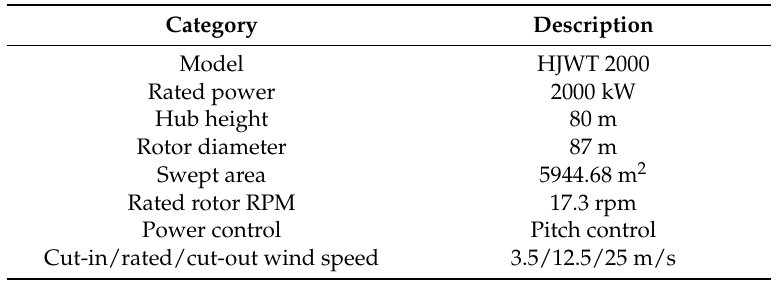
Table 1. Specification of wind turbines no. 1 and 15 under test.